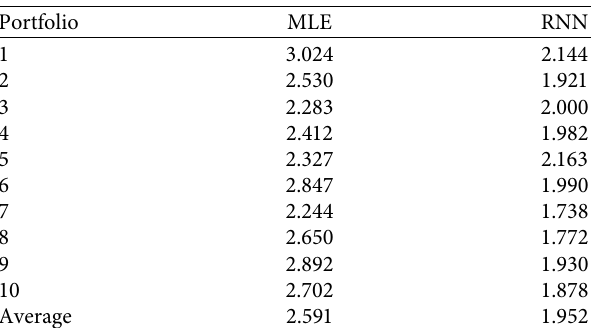
Table 4: RMSE error for 10